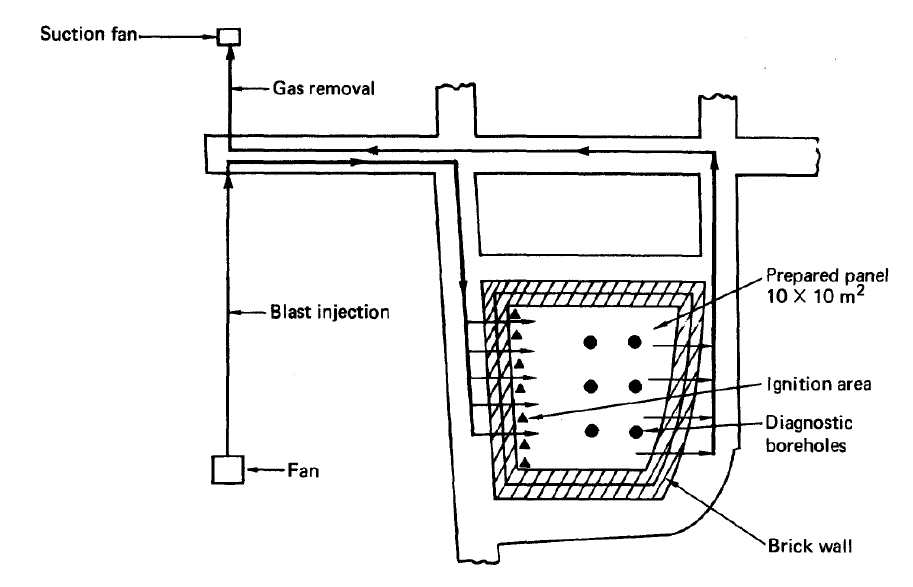
Figure 3. Outlay of the first chamber experiment at Krutova mine